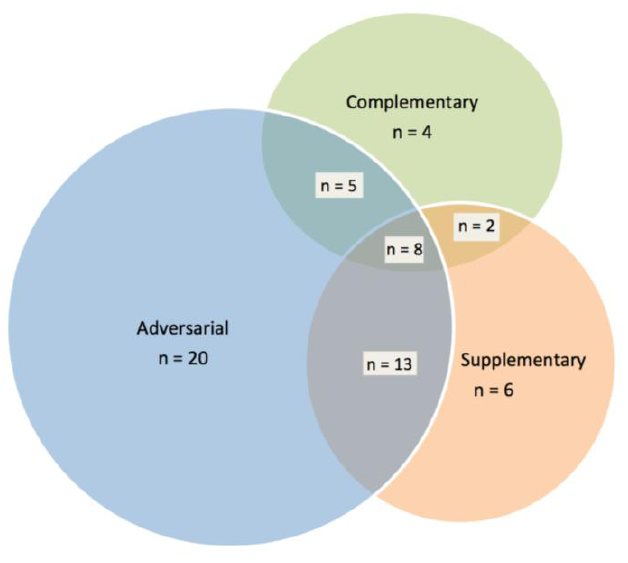
Figure 1. Mix of activities engaged in, by type, prior to